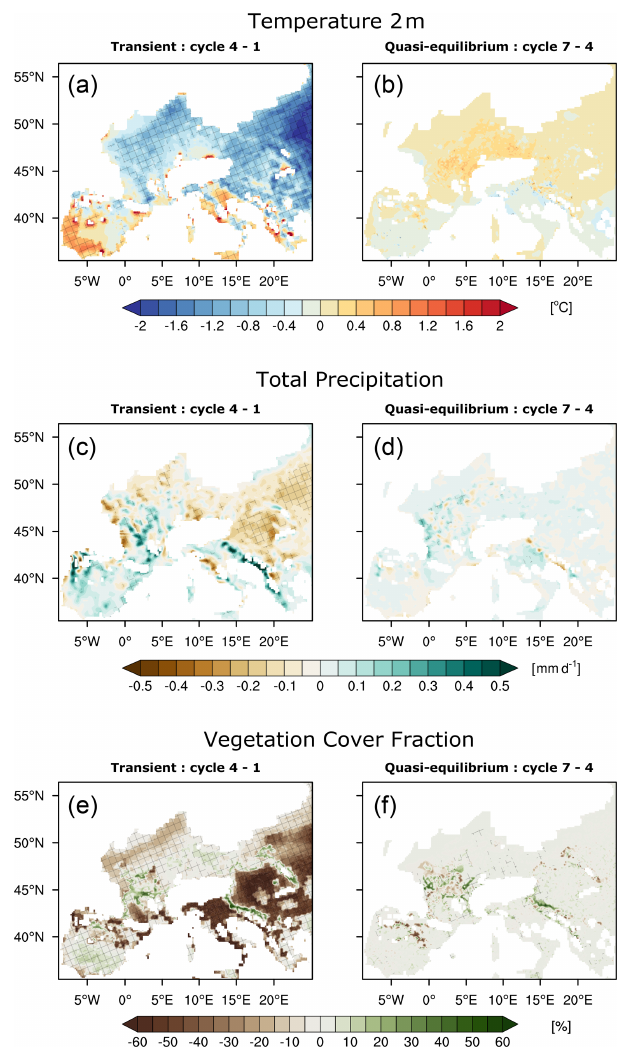
Figure 4. Differences in 30-year mean values. Panel (a) represents the difference in temperature at 2m between the first and fourth iteration (transient); (b) is the same as (a) but between the fourth and seventh iteration (quasi-equilibrium). Panels (c) – (d) and (e) – (f) are the same as (a) – (b) but for total precipitation and vegetation cover fraction, respectively. Masked out areas are in white. Crosshatched areas indicate statistically significant differences using a two-tailed bootstrapping technique with a 2% significance